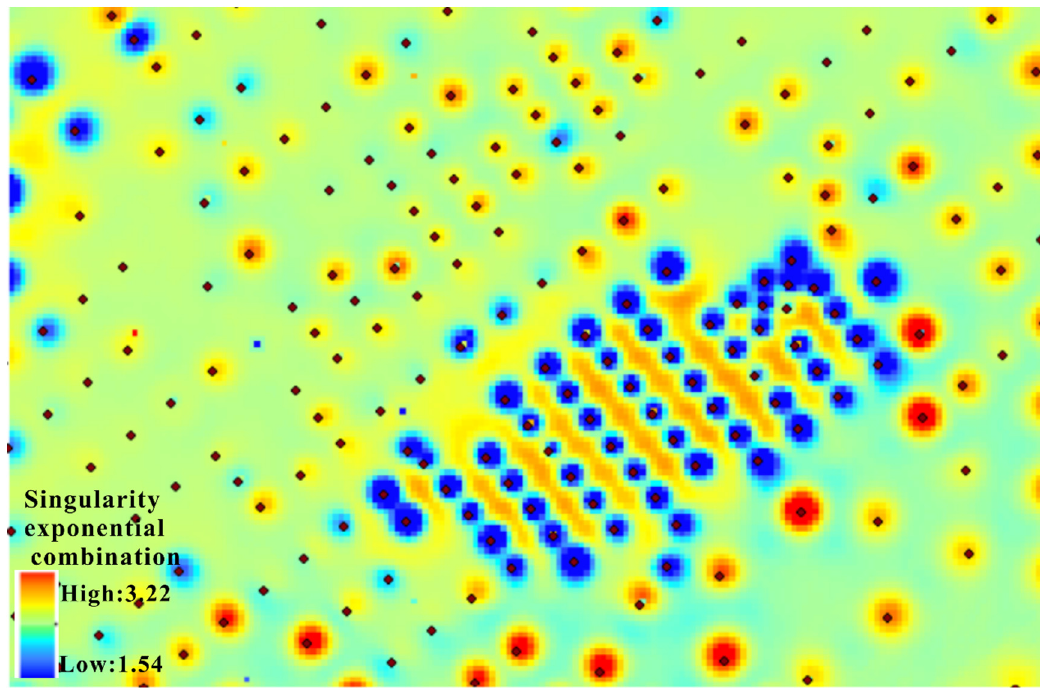
Figure 5. Principal component analysis of the singularities of W, V, Pb, Ni, Mo, Cu, Cr, Co, and Cd.